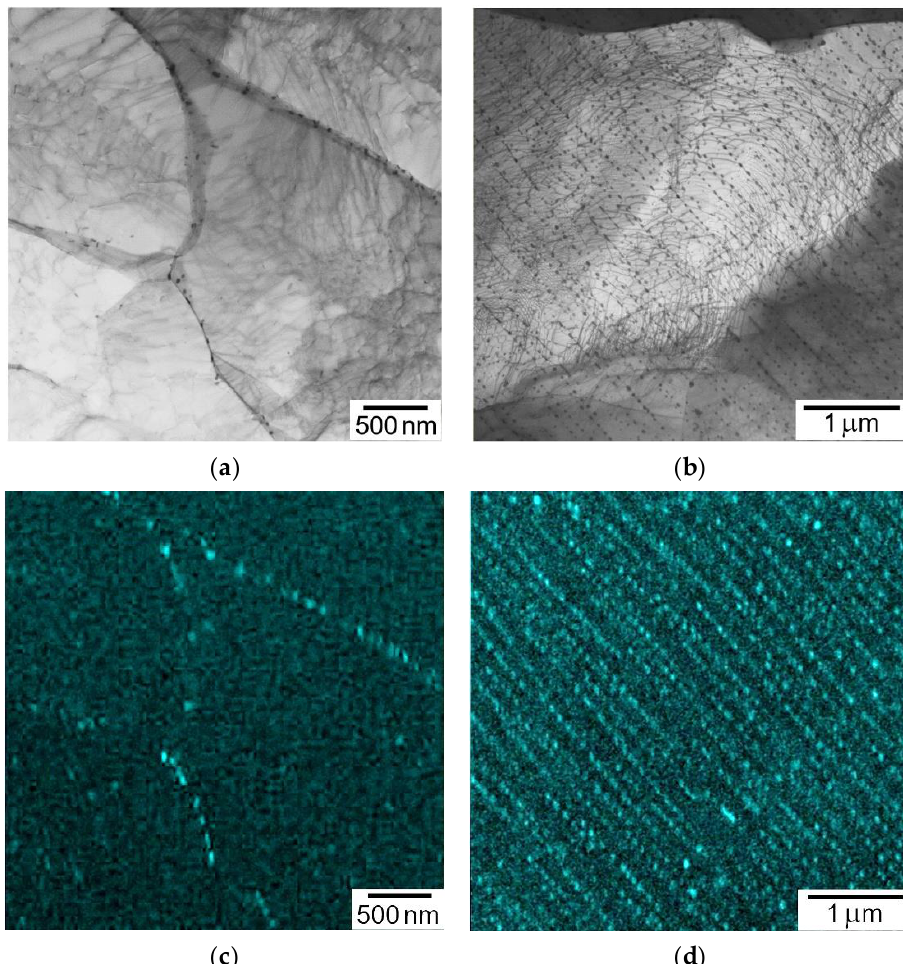
Figure 8. Scanning transmission electron microscope (STEM) bright field images ( a , b ) and EDS Hf maps ( c , d ) of the alloys taken from gauge portions of the samples corresponding to Figure 7: ( a , c ) 0.09 Hf alloy, ( b , d ) 0.33 Hf alloy.